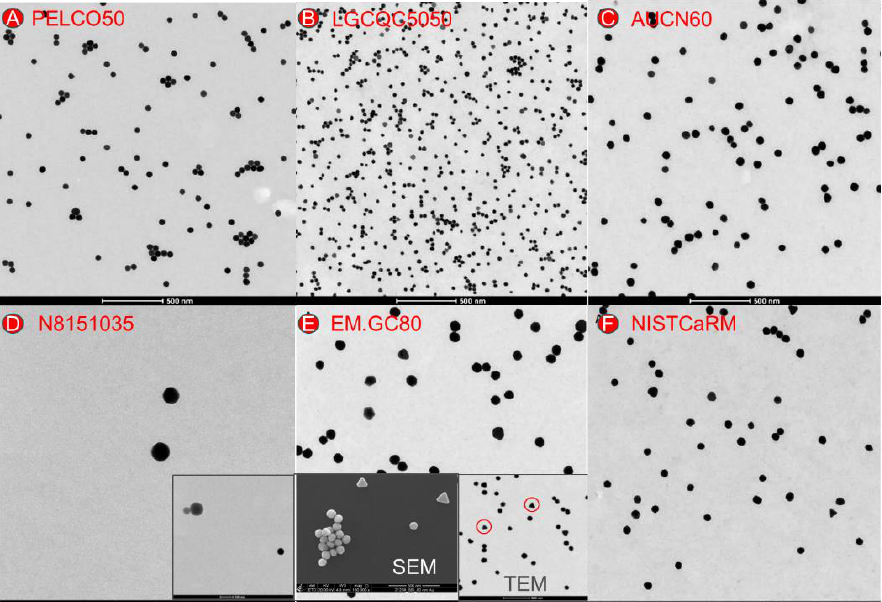
Figure 2. Annotated TEM/SEM micrographs resulting from the image analysis of the constituent particles of the six test materials (A-F). The insert for test material (D) shows - besides the gold particles - also some larger (80–100 nm) particles of lower density. Inserts for test material (E) show a subpopulation of triangular particles. Table 5. Summary of the mean and median values of the minimum Feret diameter, the Feret diameter and the equivalent circular diameter obtained from the quantitative TEM and SEM analysis of the constituent gold particles of the tested materials. TEM